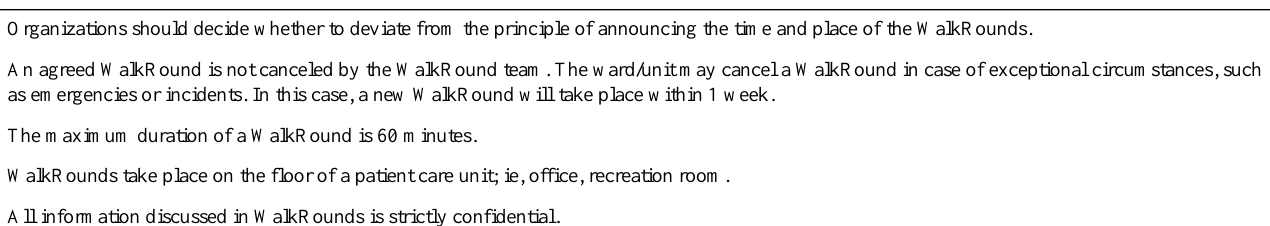
Table 3. Ground rules of